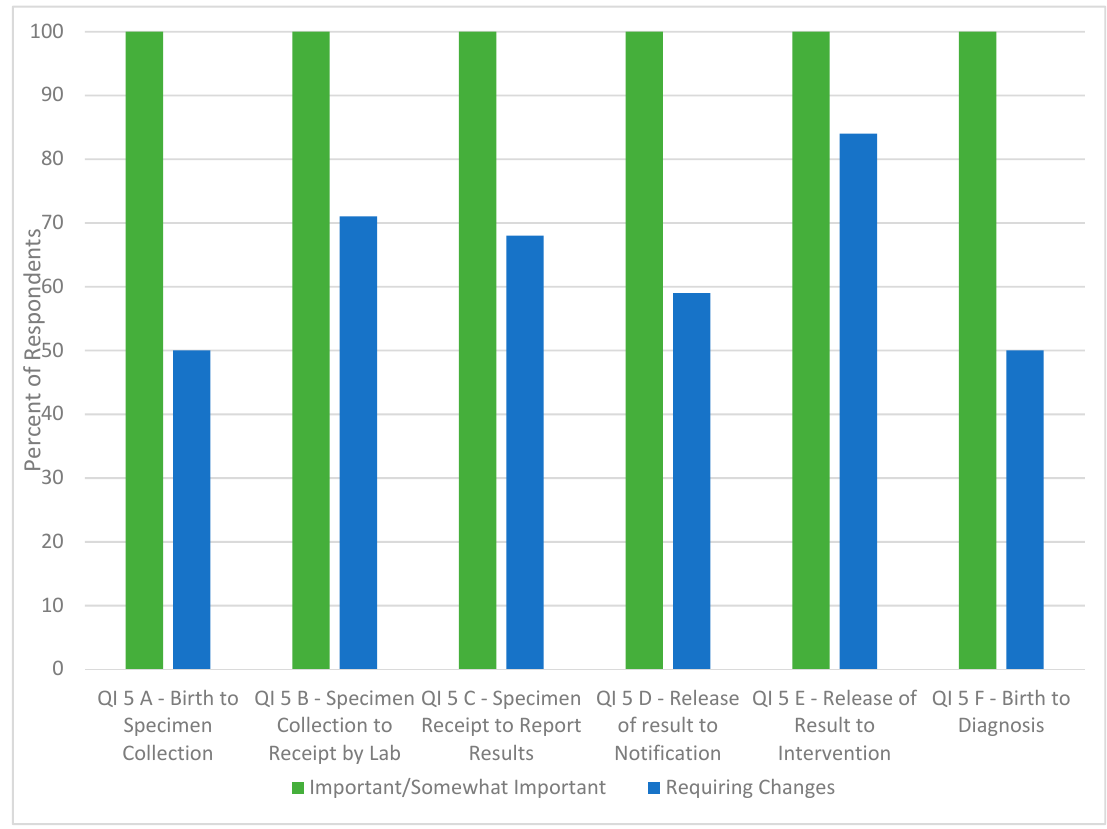
Figure 2. Electronic polling results from subject matter experts in response to importance of and degree of change required around proposed newborn screening timeliness specific quality indicators ( n = 57). Key for the QIs in Figure 2. Quality Indicator (QI) 5a: Time elapsed from birth to specimen